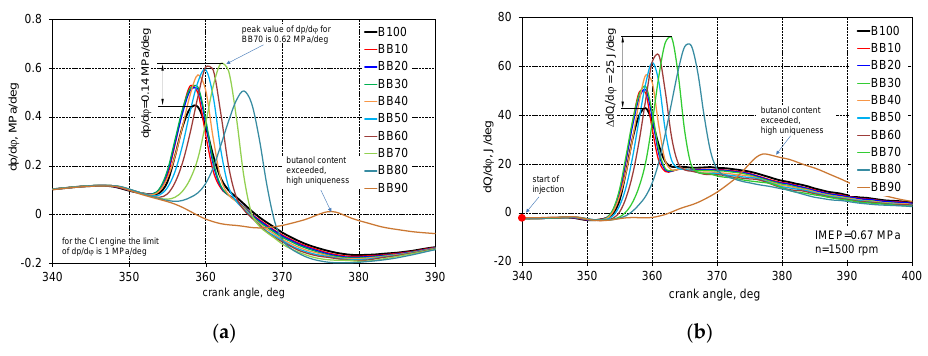
Figure 5. Pressure increase rate ( a ) and heat release rate ( b ).